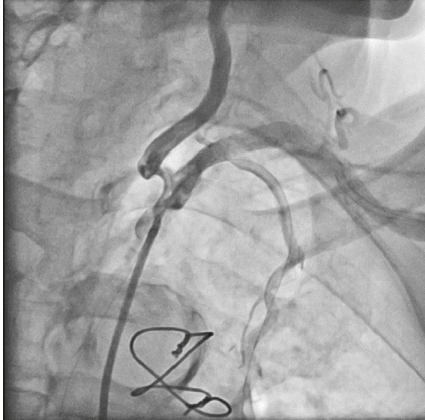
Figure 3: SA stented, trapping the LIMA wire. Persistent signif- icant disease is noted in the proximal LIMA. SA, subclavian artery; LIMA, left internal mammary